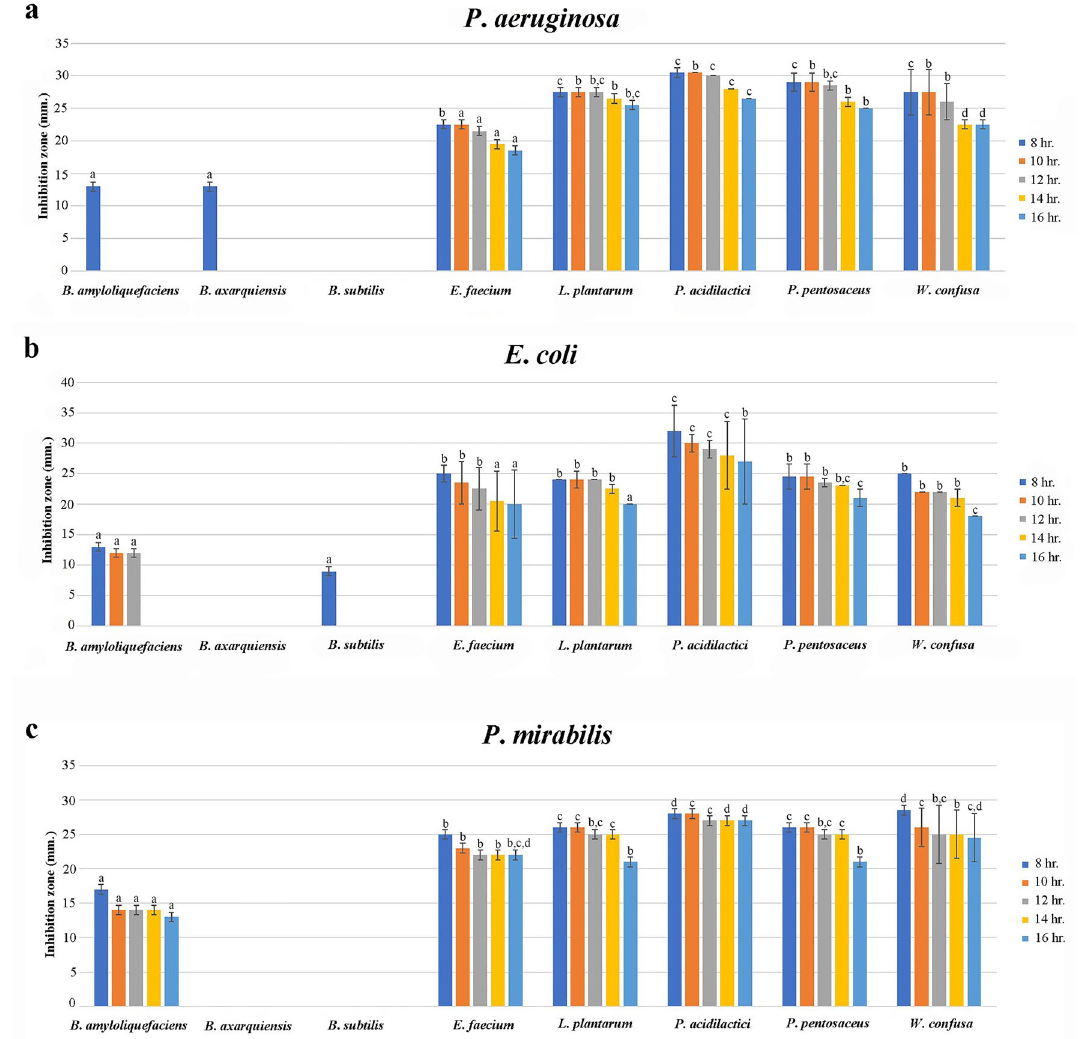
Figure 2. The antimicrobial activity at different time of CFS of probiotic against Pseudomonas aeruginosa ( a ), Escherichia coli ( b ) and Proteus mirabilis ( c ) isolated from boar semen. Note a,b,c,d Significant difference between the CFS from probiotics at the same of incubation time ( p value <